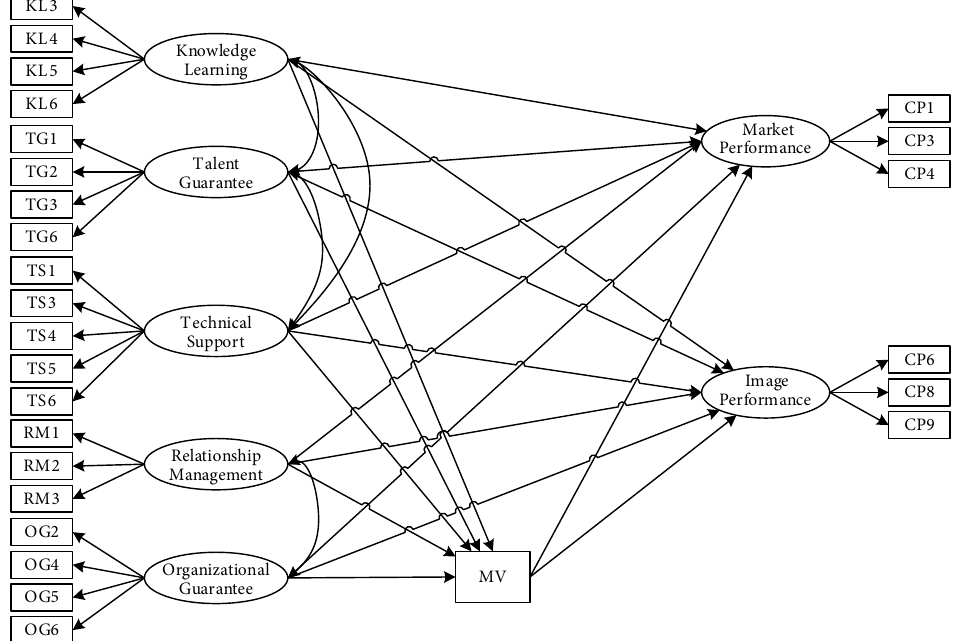
Figure 2. Baseline model of the ICS application capability to international contractors’ competitiveness